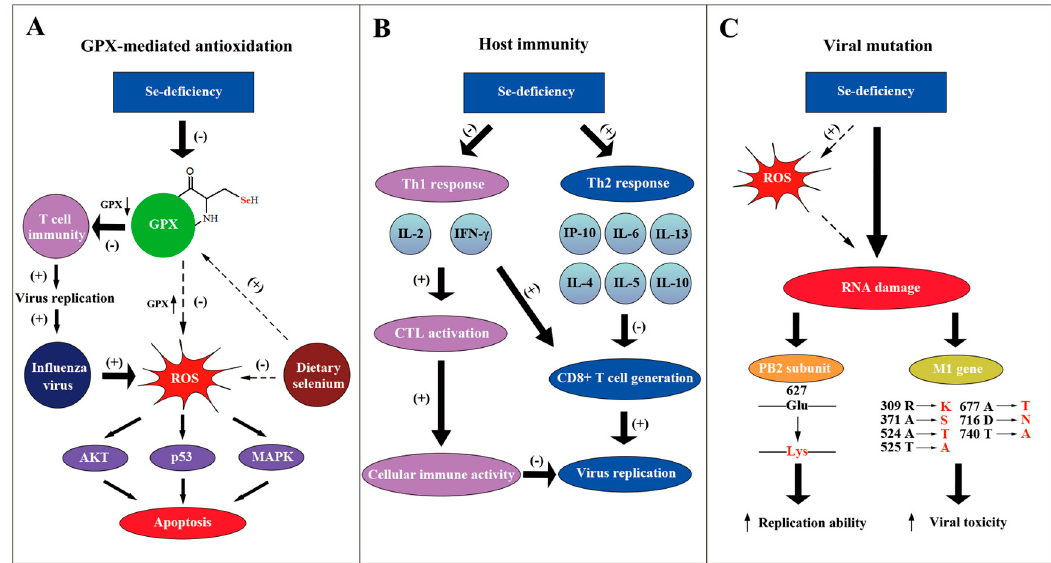
Figure 2. Molecular mechanisms of selenium against influenza virus. ( A ) The GPX-mediated antioxidation pathway participates in the anti-influenza process of selenium. Selenium functions as the vital part of GPX, which eliminates ROS. When selenium is deficient, T cell immunity is inhibited, which promotes the replication of the influenza virus. Moreover, selenium deficiency also leads to the apoptosis of the host cells through the AKT, p53 and MAPK pathways and aggravates viral cytotoxicity; supplementary selenium can suppress this negative effect. ( B ) Se-deficiency can cause the immune conversion from a Th1 response to a Th2 response. Cytokines such as IL-4, IL-5, IL-10 represented by the Th2 response whose mRNA level increased. This results in the suppression of CD8+ T cells and consequently promotes the influenza virus infection. Simultaneously, reduced Th1 responses suppress the cellular immune activity, which also increases the viral replication. ( C ) The influenza virus genome mutates when there is a lack of selenium. ROS caused by Se-deficiency, as one of the possible mechanisms, can directly damage the viral genome and give rise to mutations. It was demonstrated that PB2 gene and M1 gene could mutate to produce viral strains that had a stronger replication ability and a higher toxicity in a low selenium